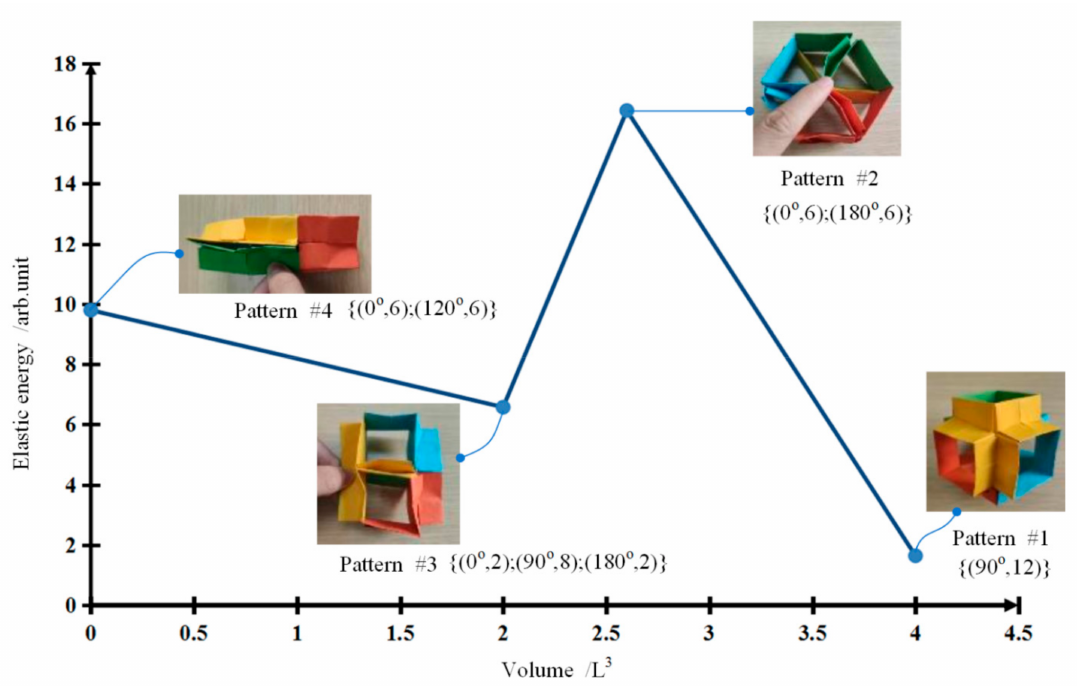
Figure 2. Shape shifting, energy landscape and cavity volume of rhombic hexahedron